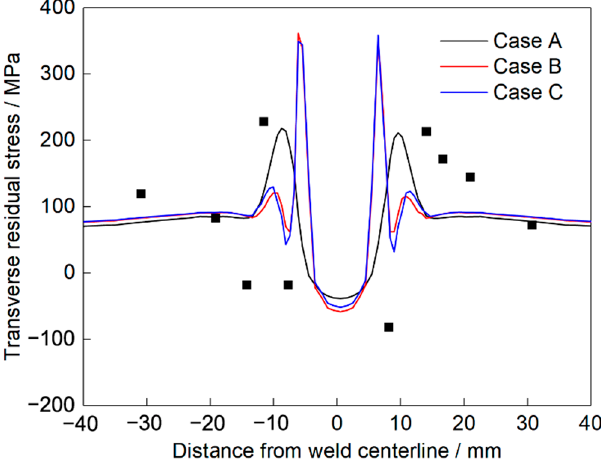
Figure 20. Computational and experimental results of transverse welding residual stress distribu- tion.